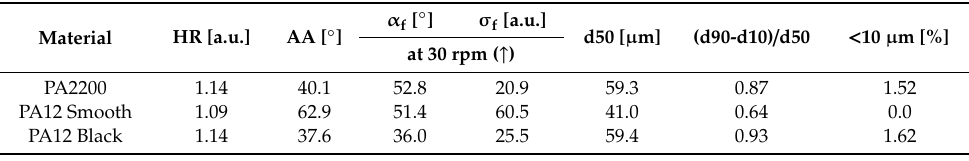
Table 3. The Hausner Ratio (HR), First Avalanche Angle, Flowing Angle, Cohesive Index and Particle Size Distribution of Di ff erent Machine Manufacturer’s Polyamide 12 Powders.